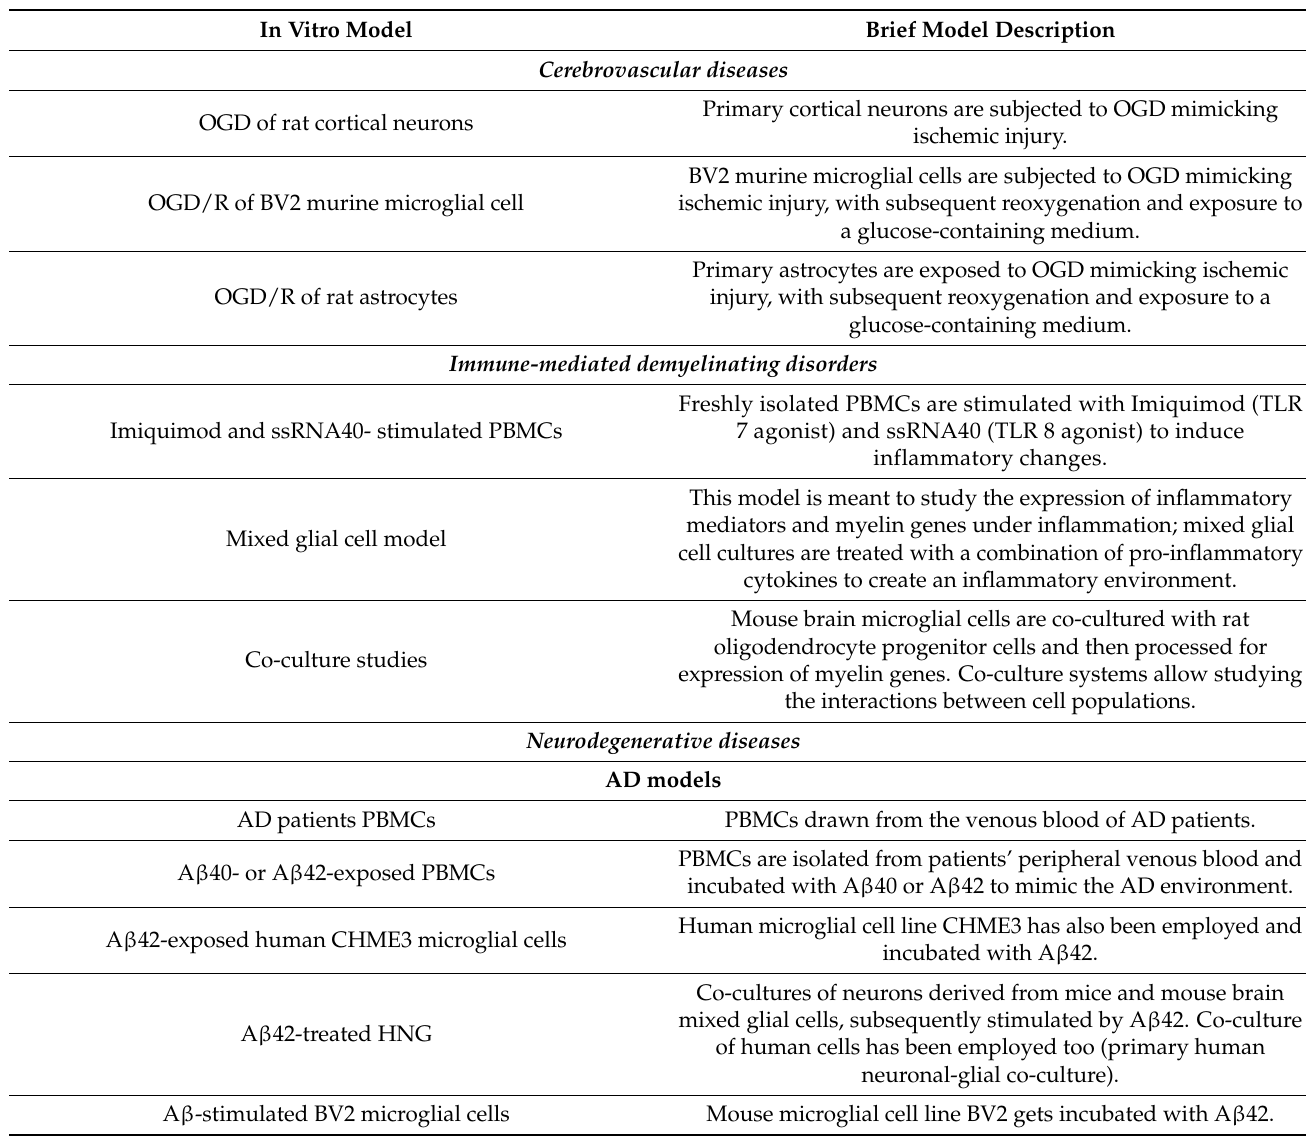
Table 4. Overview of the main in vitro models currently used in the field of neurological disease and SPMs